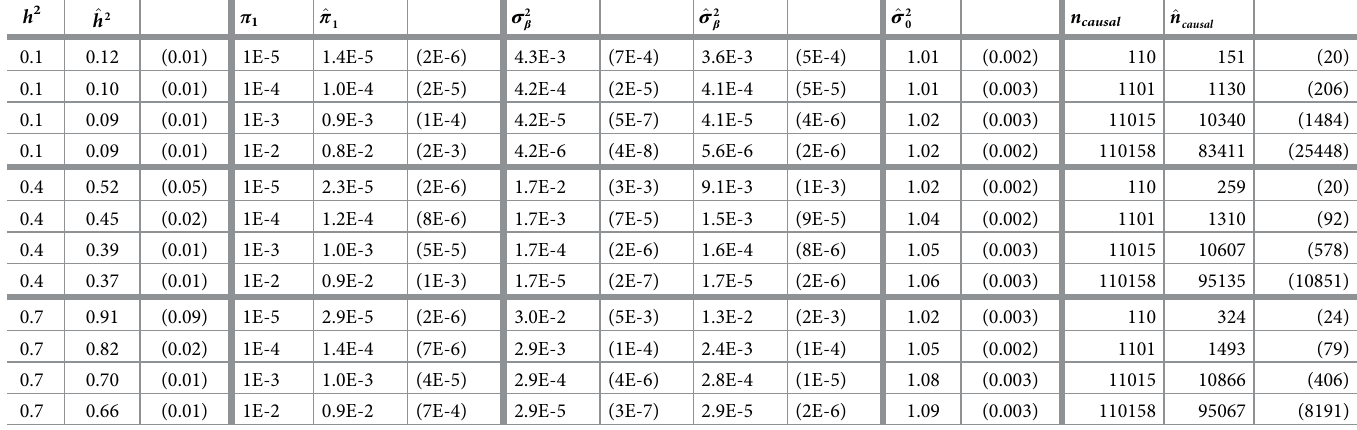
Table 1. Simulation results: Comparison of mean (std) true and estimated (^) model parameters and derived quantities. Results for each line, for specified heritability h 2 and fraction π 1 of causal SNPs, are from 10 independent instantiations with random selection of the n causal causal SNPs that are assigned a β -value from the standard normal distribution. Defining Y = G β , where G is the genotype matrix, the total phenotype vector is constructed as Y = Y + ε , where the residual random vector ε for each g g instantiation is drawn from a normal distribution such that var( Y ) = var( Y )/ h 2 for predefined h 2 . For each of the instantiations, i , this implicitly defines the true value s 2 , g b i and s 2 is their mean. An example QQ plot for each line entry is shown in in S1 Appendix (p. b